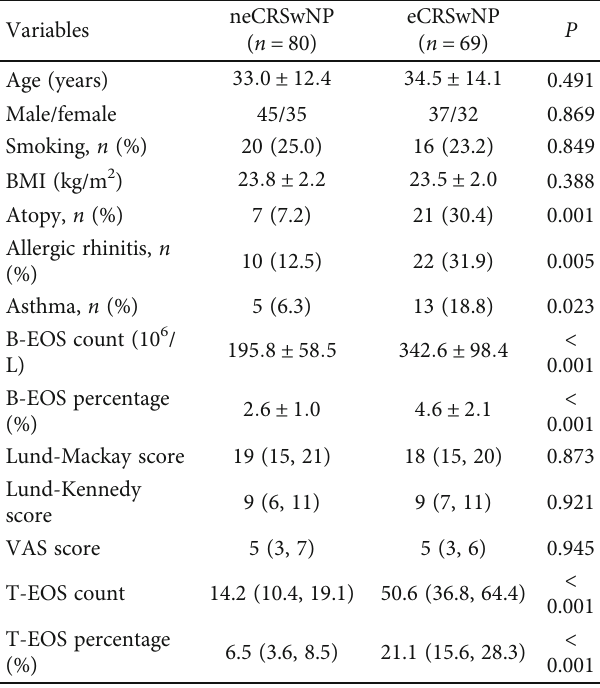
Table 2: Comparison of demographic and clinical characteristics between the neCRSwNP and eCRSwNP